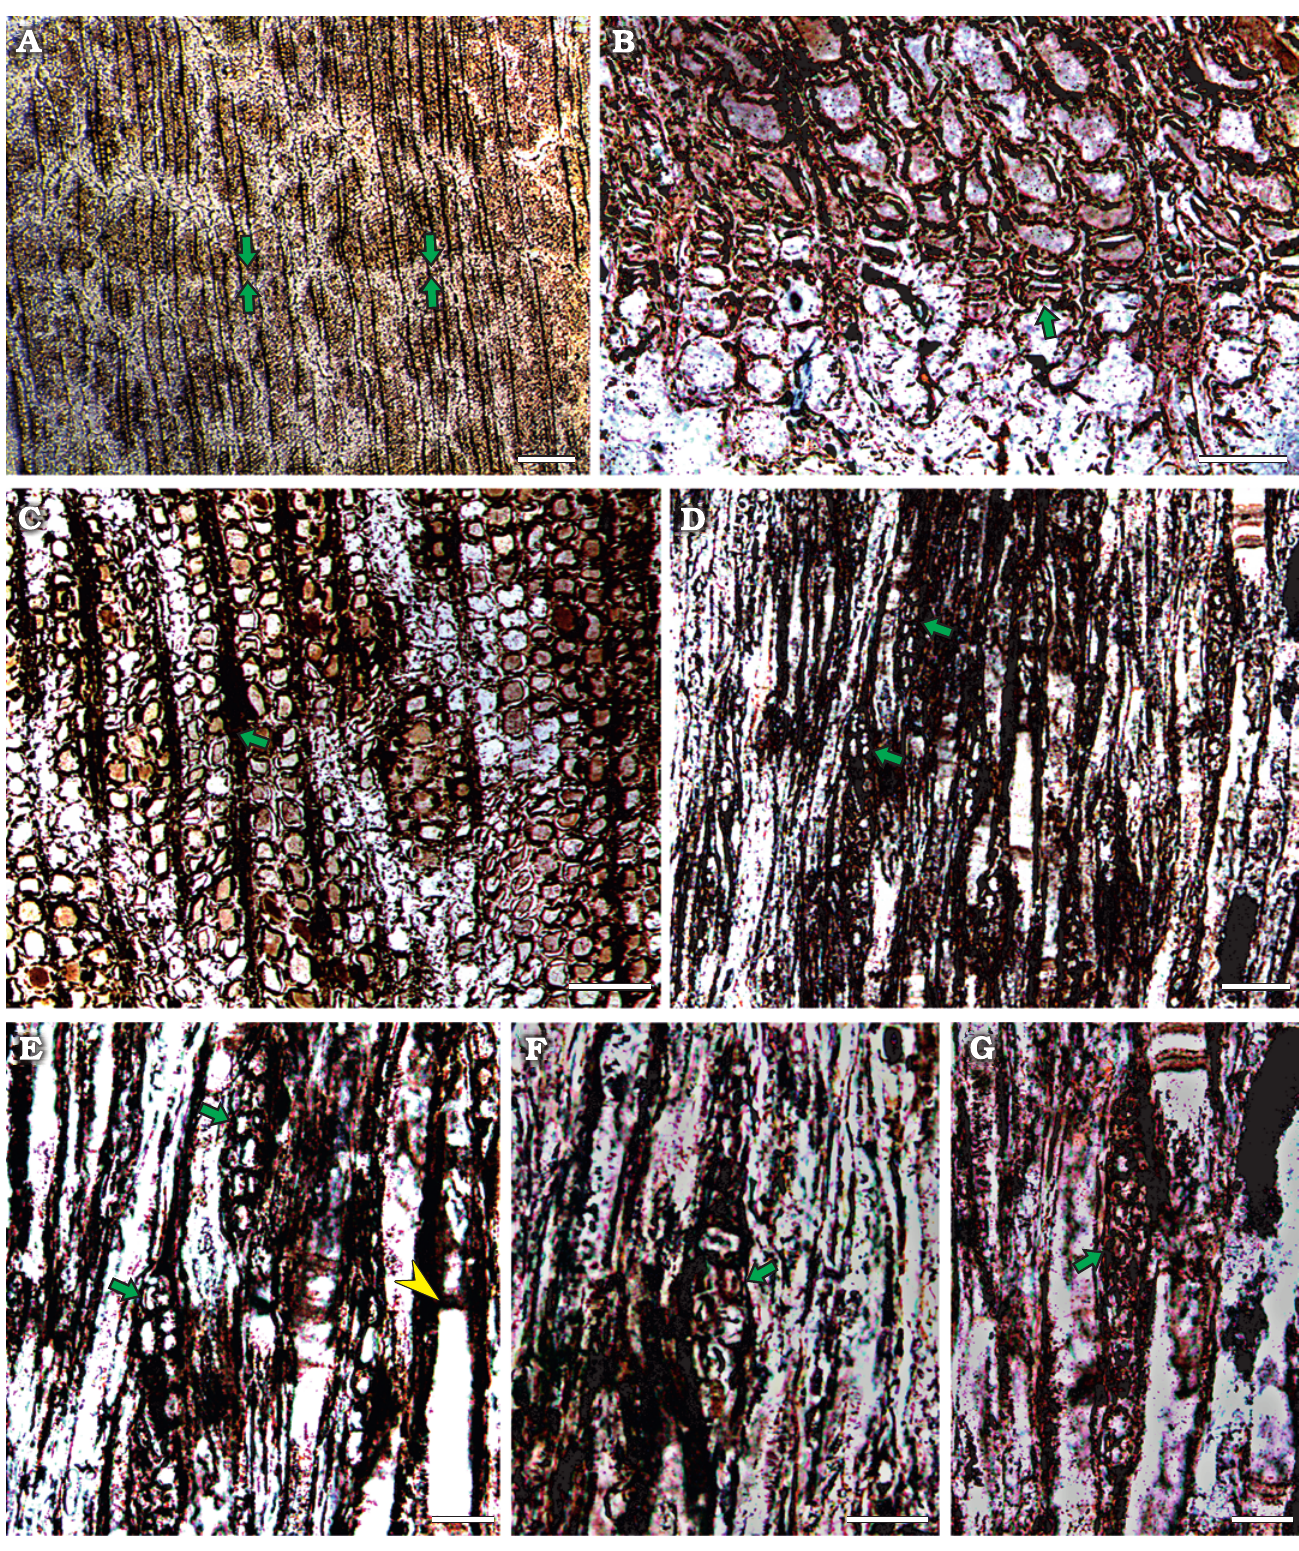
Fig. 6. Araucarian wood Agathoxylon mendezii sp. nov. (MPM­PB­15596), Estancia El Álamo, Santa Cruz Province, Argentina, Berriasian–Valanginian. Wood sections observed under LM. A – C . Transverse view. A . Slightly marked growth ring (arrows). B . Detail of growth ring, arrow shows layers of rectangular­flattened latewood tracheids. C . Detail of earlywood tracheids and rectilinear trajectory of rays (arrow). D – G . Longitudinal tangential view. D . General aspect, arrows indicate partially biseriate rays. E – G . Details of biseriate rays (arrows), arrowhead shows resin plugs. Scale bars: A, 500 µm; B, C, 150 µm; D–G, 100